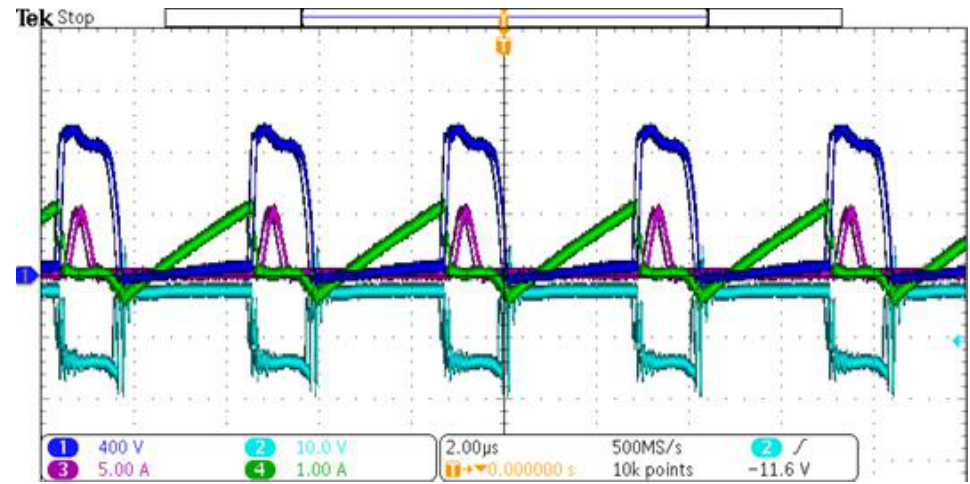
Figure 16. Example of the bistable case.